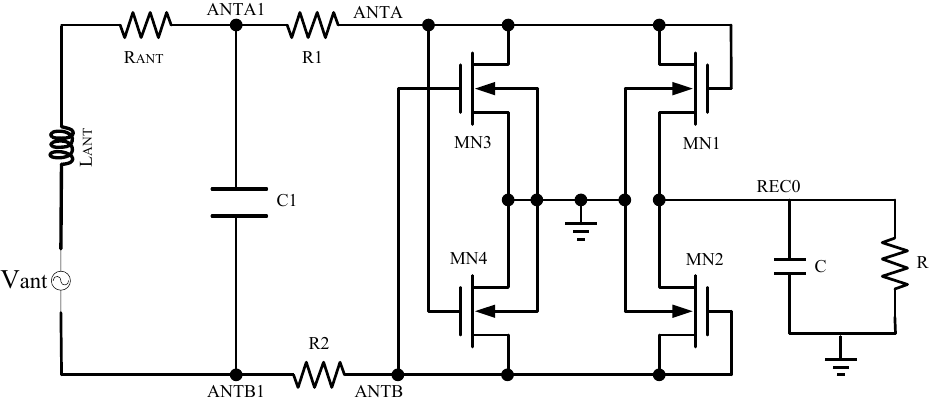
Figure 2. NMOS gate cross-connected bridge